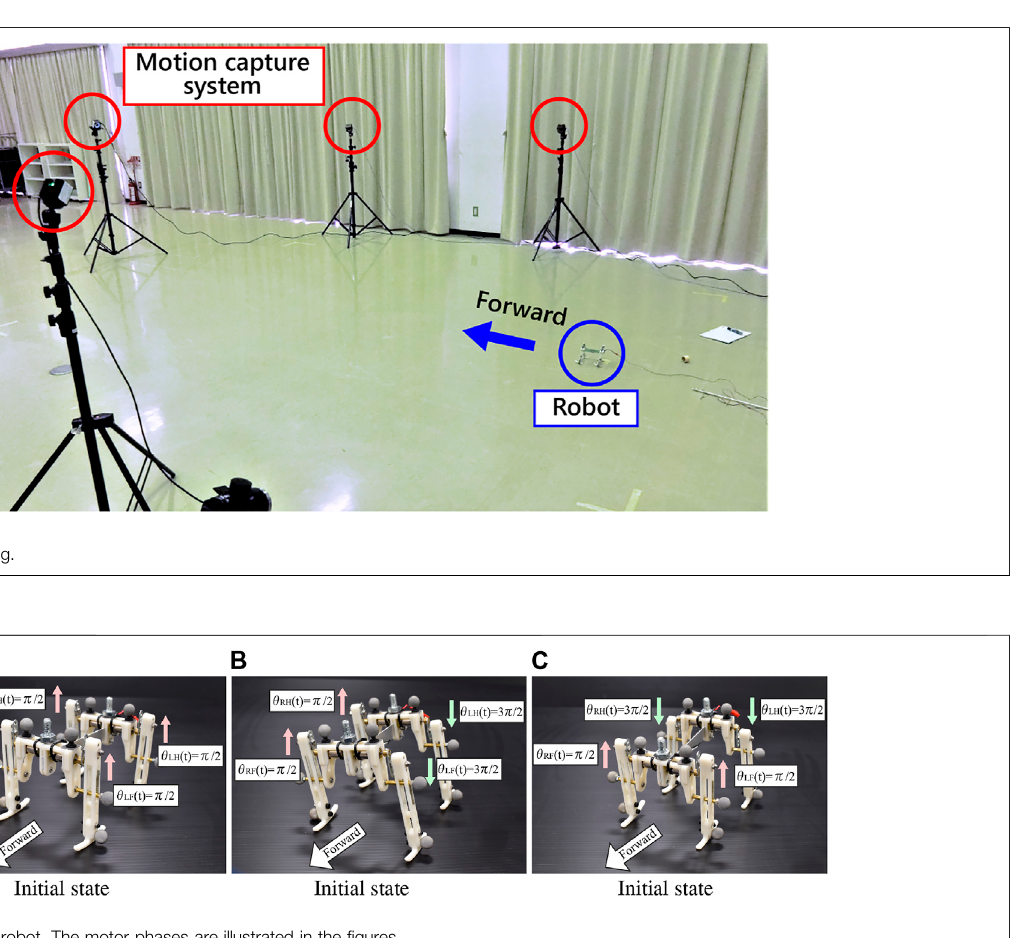
FIGURE 6 | Initial states of the robot. The motor phases are illustrated in the fi gures.